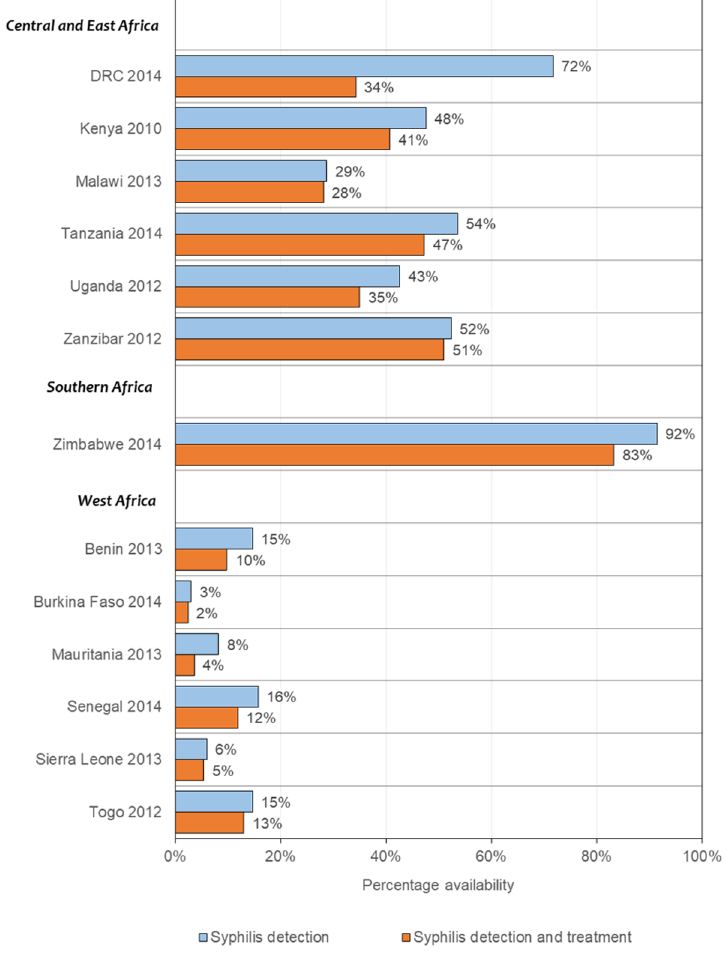
Fig 1. Availability of syphilis detection and treatment in health facilities offering antenatal care (ANC) in 12 sub- Saharan African countries, 2010–2015. DRC: Democratic Republic of Congo.